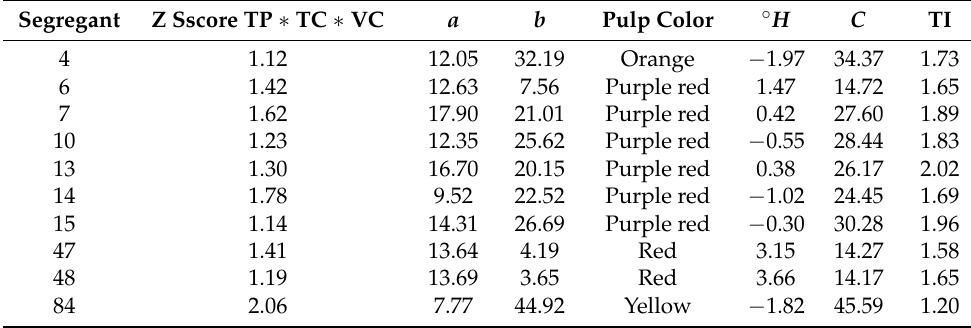
Table 5. Z Score values, and color parameters of selected elite individuals.